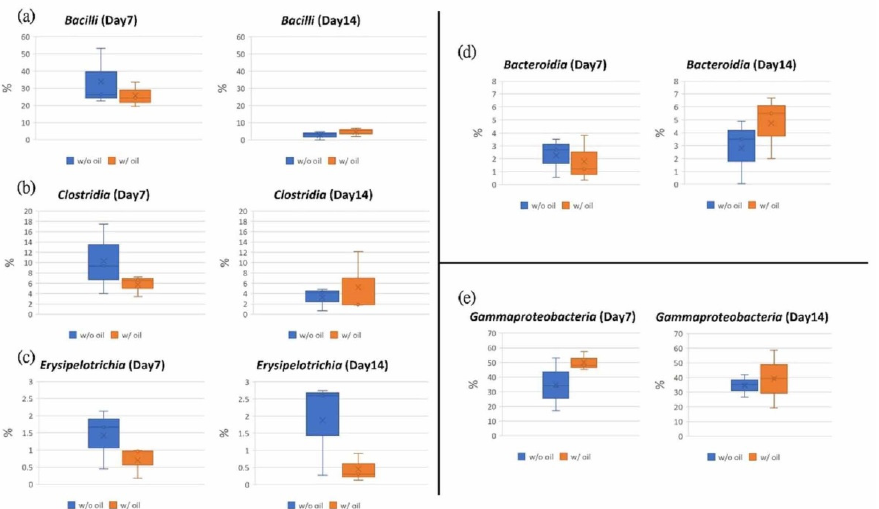
Figure 7. Tested teeth were subjected to ligature-induced periodontitis. Data from samples treated with and without SM oil were compared. Sub-figures showed the box plot analysis in the class of